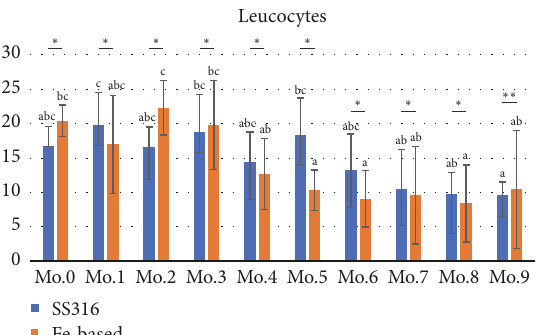
Figure 4: The number of leucocytes in tibial shaft fracture dur- ing 9 months of observation time after implantation in sheep. ∗ insignificantdifferencesand ∗∗ significantdifferencebetweenboth groups in same observation times (P > 0.05). Mo: